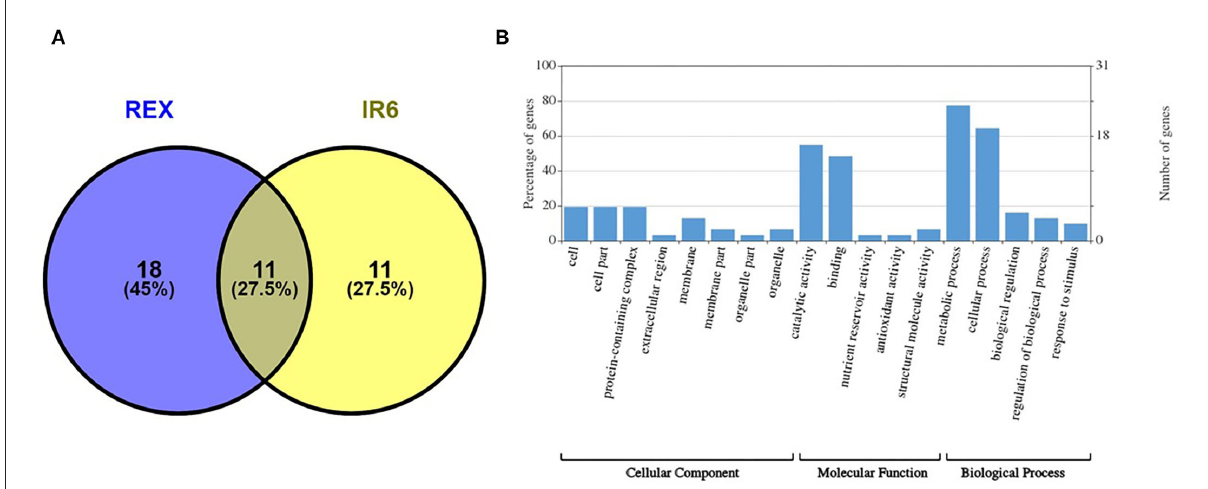
FIGURE3 (A) Venn diagram showing the differentially expressed proteins in the cultivars REX and IR6 (B) GO enrichment analysis of identified proteins. The number of proteins enriched with each GO term in one of the three categories, including biological process, molecular function, and cellular component, is